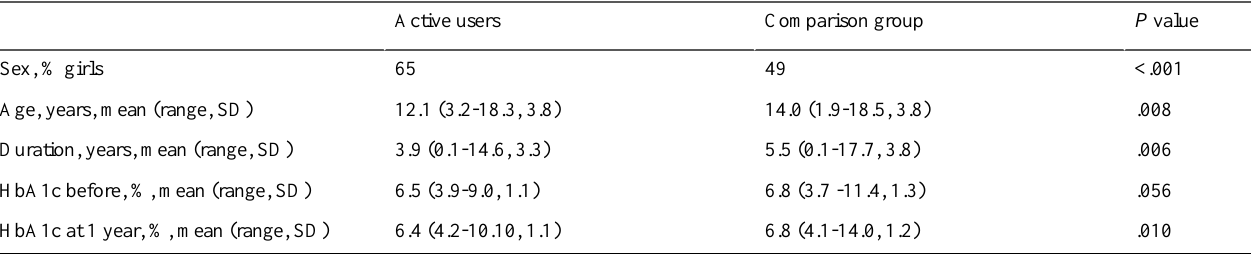
Table 3. Active users (5 visits or more) as compared to less active (0-4 visits), including most recent HbA1c before access and at the end of 1 year of